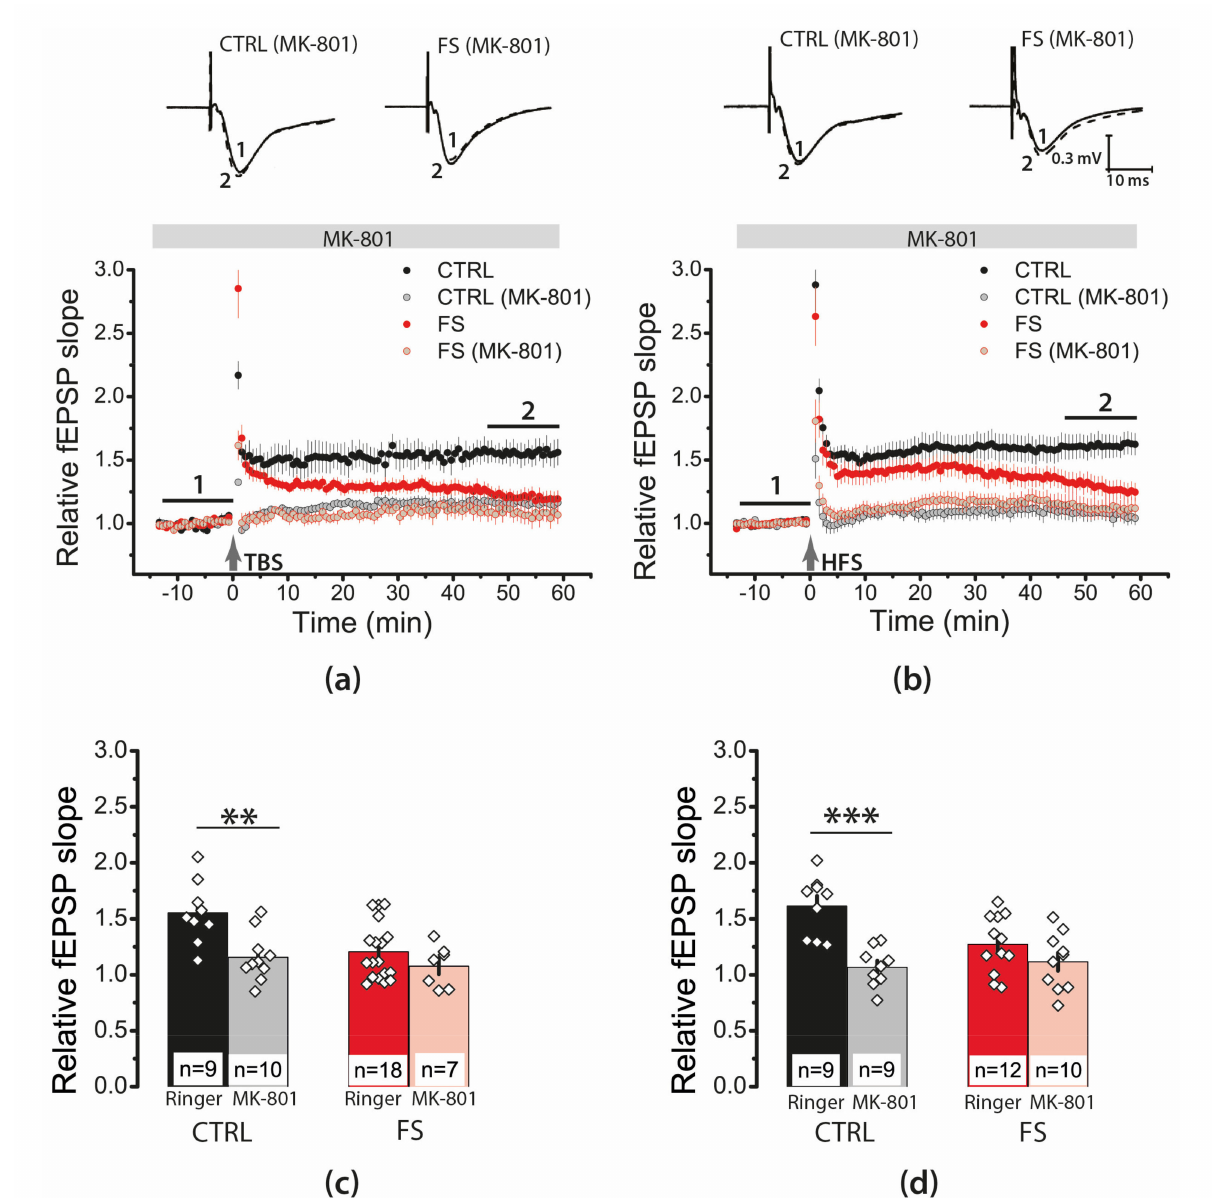
Figure 5. LTP induction in the CA1 hippocampus of juvenile animals after early life FS was NMDAR-dependent. The normalized fEPSP slope in the control and experimental groups in the presence of the NMDAR blocker MK-801 (10 µ M), before and after TBS ( a ) or HFS ( b ). ( c , d ) Diagrams illustrating the magnitude of plasticity in the control and experimental groups in the presence of MK-801, after TBS ( c ) or HFS ( d ). Note that no synaptic plasticity was detected in the presence of MK-801 in any group. Two-way ANOVA following Tukey post hoc tests were used. ** p < 0.01, *** p <